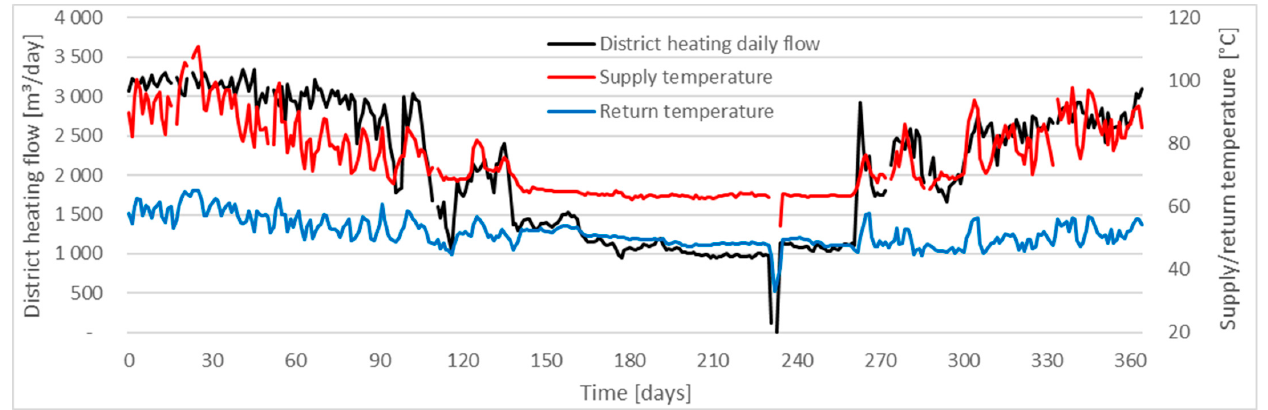
Figure 3. Annual data recorded in the heating plant (supply/return temperature, district heating water flow).